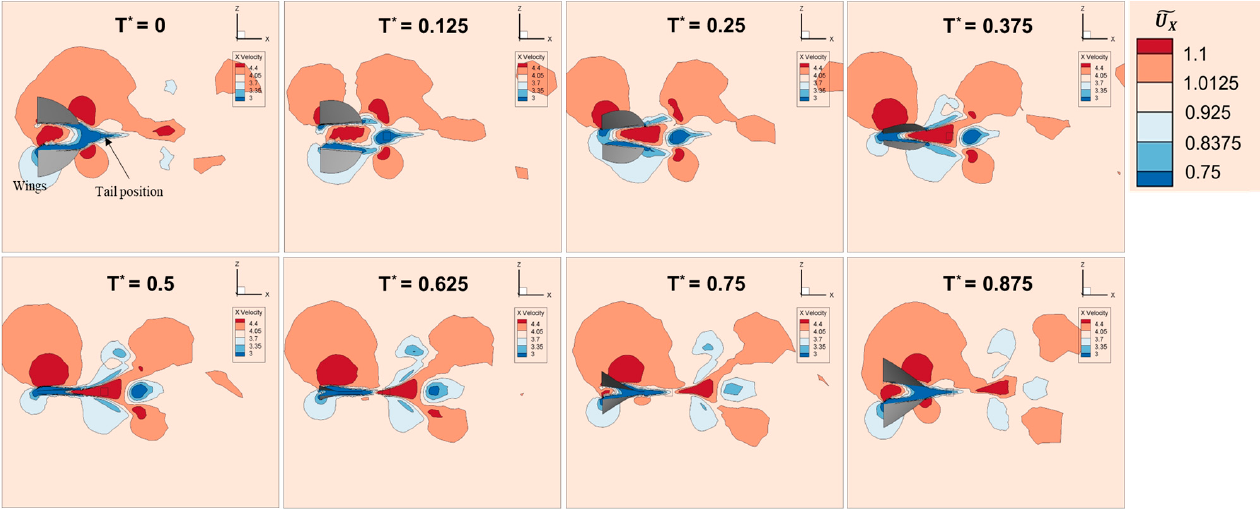
Figure 25. X-velocity distribution in the section of y = 0.175 span.